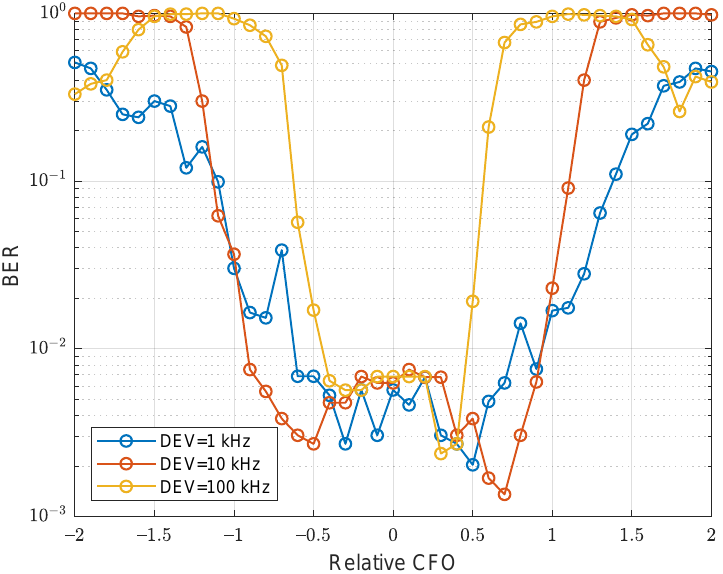
Figure 14. BER versus relative CFO with the strobe-based detector in the single model scenario. DEV—FM deviation. The receiver gain is 10 dB, and the transmitter gain is − 26 dBm.